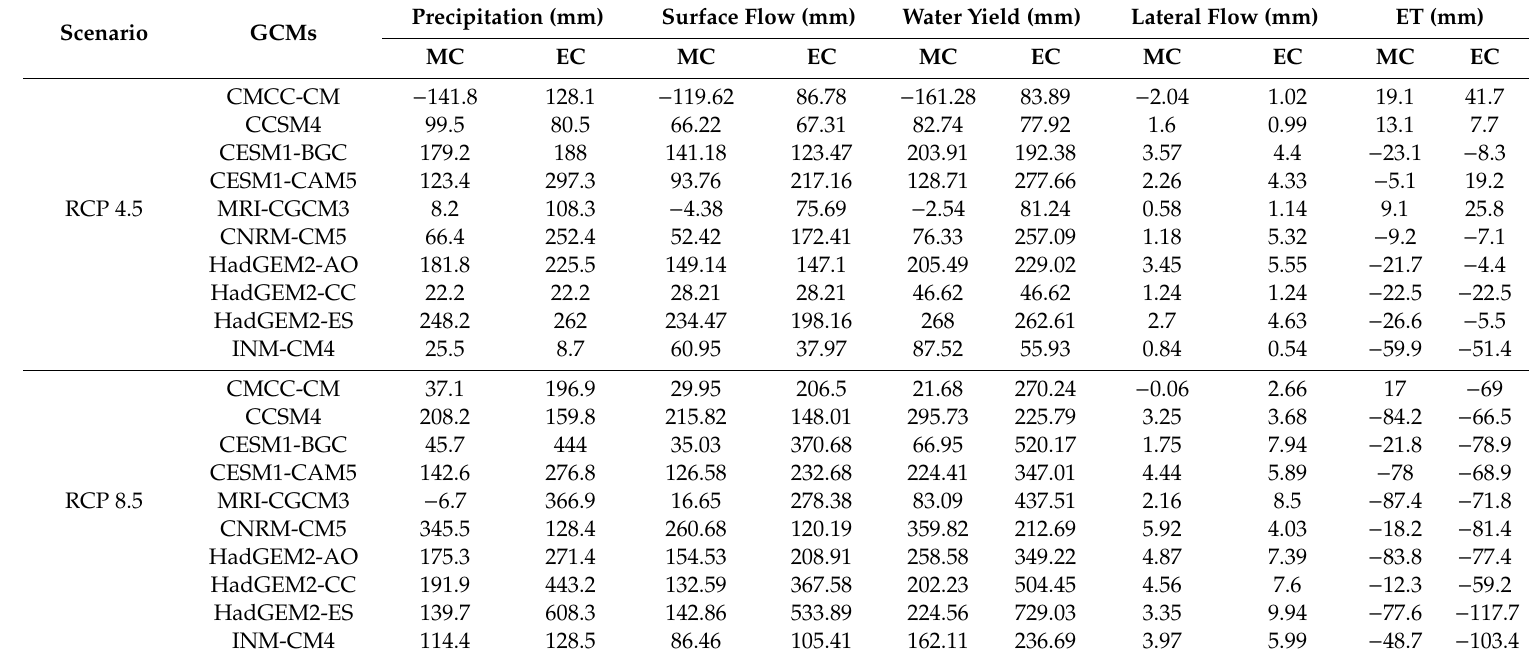
Table 6. Variability amongst the 10 GCMs used in the